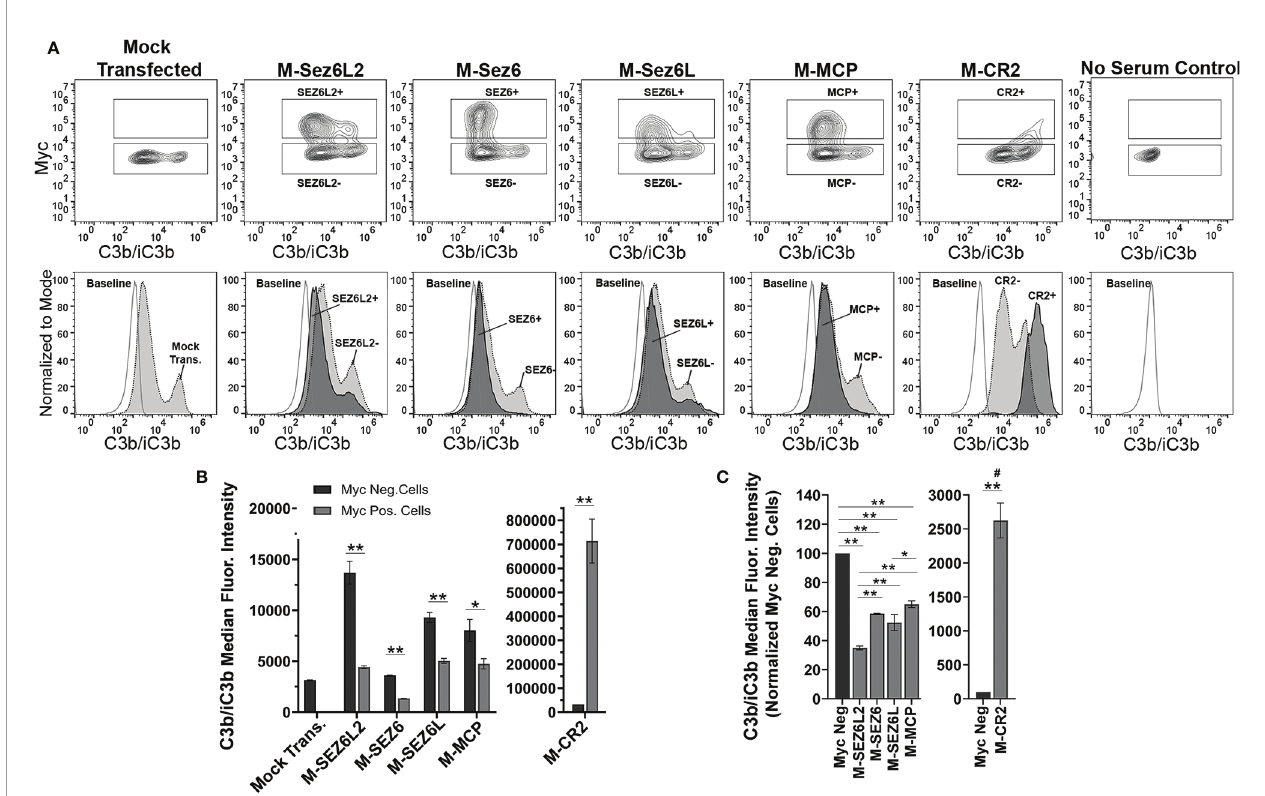
FIGURE 3 | Full Length Sez6L2, Sez6, and Sez6L inhibit C3b/iC3b opsonization of CHO cells by the alternative pathway. CHO cells were transfected with the indicated Myc-tagged cDNAs and then coated with a low level of antibodies and exposed to 20% C5-depleted human serum for one hour in the presence of 10 mM EGTA and 10 mM MgCl 2 to block the classical pathway. Cells were then labeled with anti-C3b/iC3b and anti-Myc antibodies and analyzed by fl ow cytometry. (A) 5% Contour plots of C3b/iC3b versus Myc fl uorescence (top layer) and C3b/iC3b fl uorescence histograms (bottom layer) of the same samples normalized to mode and compared to baseline cells not exposed to serum. For Contour plots, boxed regions highlight cells designated as Myc-positive (top box) and Myc- negative (lower box) populations. For C3b/iC3b histograms, dark grey, solid line population = Myc-positive cells; Light grey, dotted line population= Myc-negative cells; White, dashed grey line population = baseline. Representative of 3+ independent experiments with technical replicates. (B) Quanti fi cation of the average median C3b/iC3b fl uorescence intensity from Myc-positive and Myc-negative cells within each sample. N=3 (one experiment with three replicates; Representative of 3+ independent experiments) Statistics = t-tests. E) Average median C3b/iC3b fl uorescence intensities after normalization to the Myc-negative cells from each experimental group. ANOVA (p<0.001; F(4, 10)=74.47. N=3 (3 independent experiments). For all graphs *p < 0.05; **p < 0.01 # p < 0.001 for all Myc-positive groups compared to